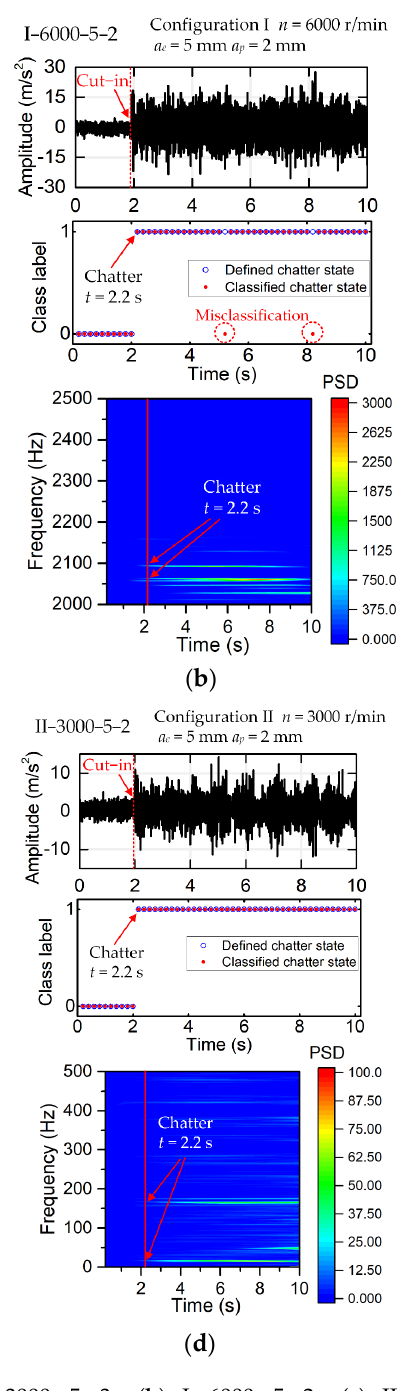
Figure 9. Detection results for: ( a ) I − 3000 − 5 − 3; ( b ) I − 6000 − 5 − 2; ( c ) II − 3000 − 5 − 1; ( d ) II − 3000 − 5 − 2.